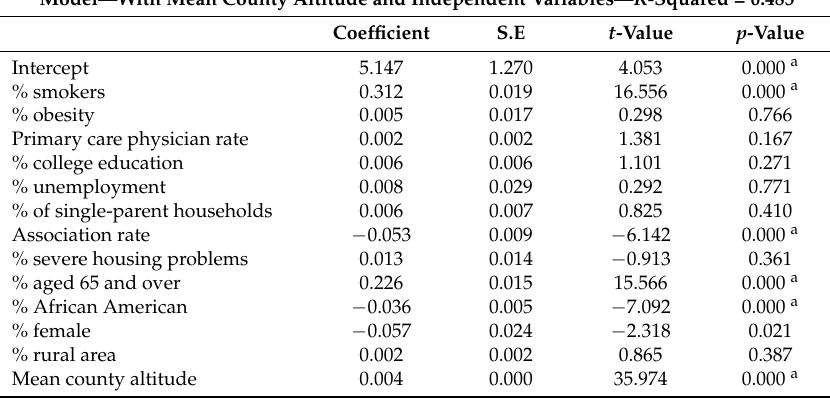
Table 2. OLS regression analyses of all independent variables for suicide rates in the NCHS. Model—With Mean County Altitude and Independent Variables— R -Squared =